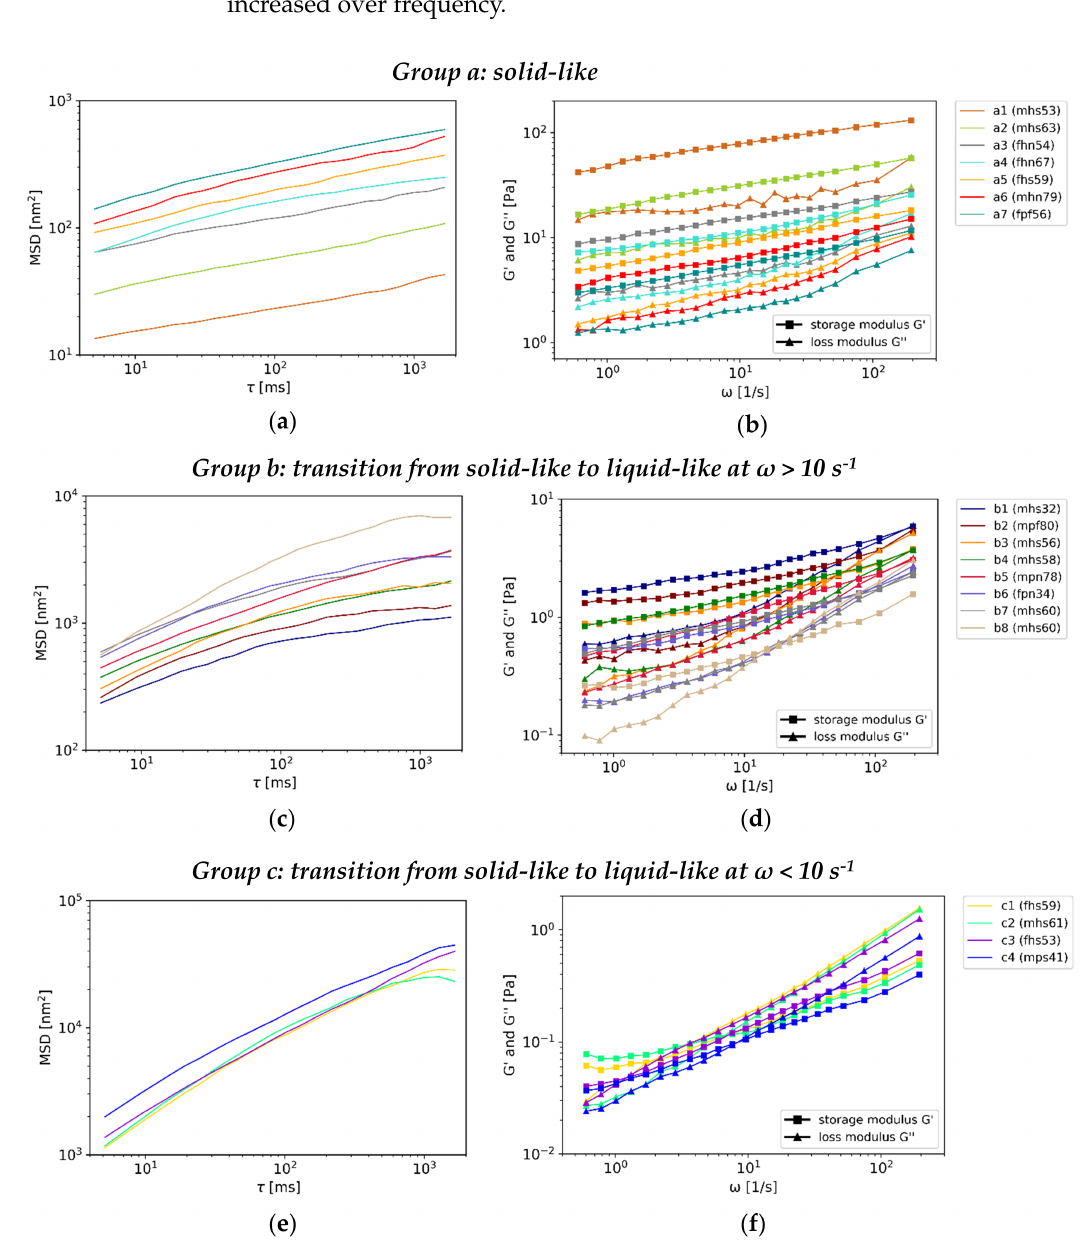
Figure 2. MSDs and viscoelastic properties of mucus samples, subdivided into three groups. ( a ) MSD group a; ( b ) viscoelasticity group a; ( c ) MSD group b; ( d ) viscoelasticity group b; ( e ) MSD group c; ( f ) viscoelasticity group c. Group a mucus samples revealed the lowest MSDs, the highest loss and storage moduli and throughout gel character. MSDs increased from group a over b to c. Hence the storage and loss moduli decrease. Group b and c mucus samples revealed a crossover of the moduli. The abbreviations in the brackets give information about the patients’ demographic data belonging to the mucus samples: 1. digit: gender (f: female, m: male); 2. digit: larynx status (h: healthy, p: pathologic); 3.